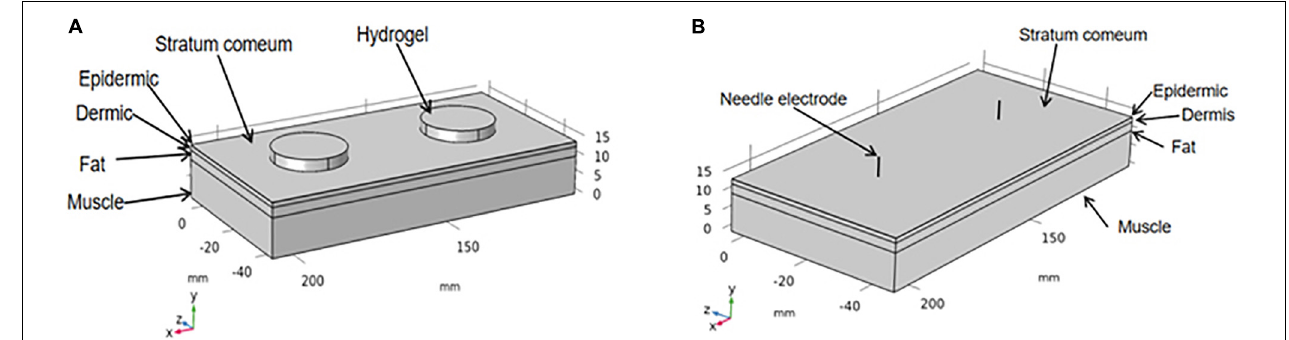
Frontiers in Neuroscience |